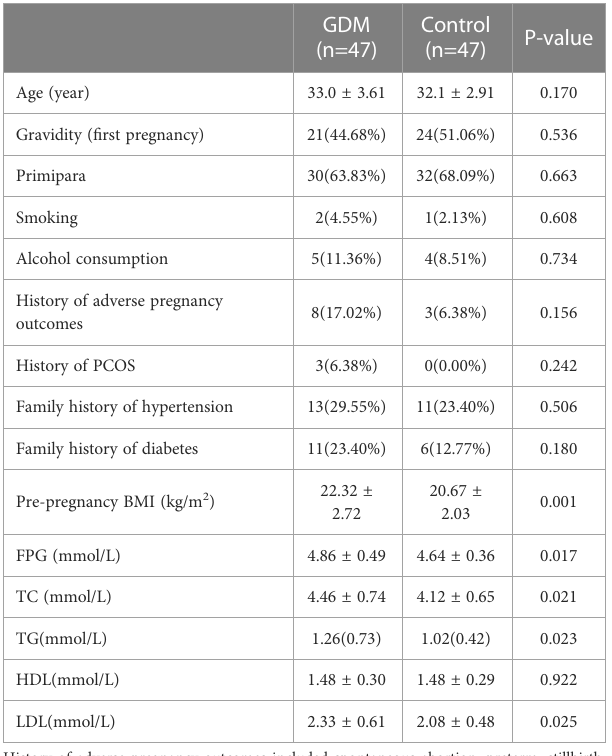
TABLE 1 Baseline characteristics and glycolipids metabolism in the fi rst trimester between two